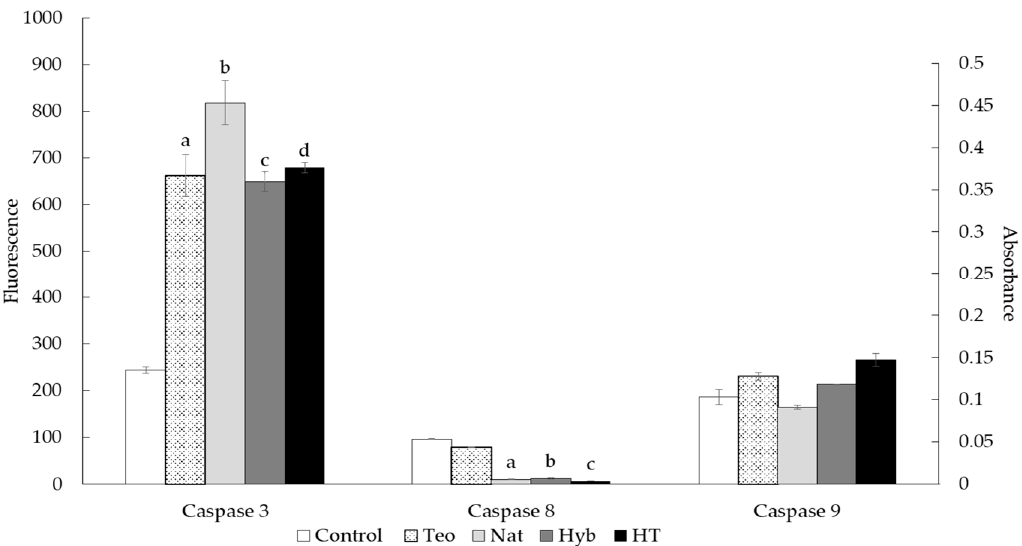
Figure 2. Caspase activity measured in HepG2 cells treated with half-maximal inhibitory concentration (IC 50 ) of the peptides obtained from zein of the four Zea varieties. Cells left untreated were used as controls. Caspase 3 activity: fluorescence was measured at excitation 485 ± 10 nm and emission 530 ± 12.5 nm at the indicated times. Caspase 8 activity: fluorescence was measured at excitation 400 nm and emission 505 nm. Caspase 9 activity: absorbance was measured at 400 nm. Results are expressed as mean values ± standard deviation ( n = 4). Treatments that were significantly different are shown with different letters ( p < 0.05).